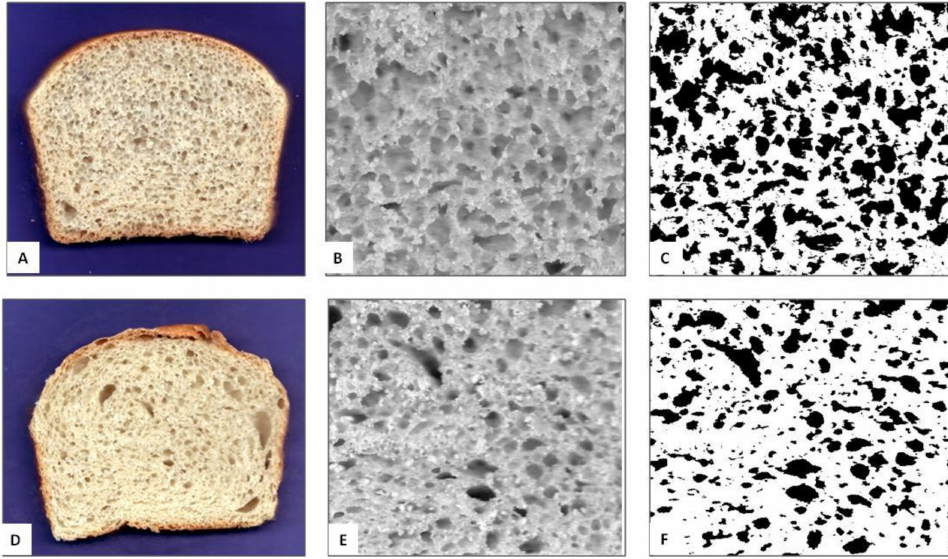
Figure 1. Representative images of the bread samples, regions of interests and the binarized images employed for morphological characterization of crumb structure. ( A , D ) represent CB and GFB, respectively; ( B – E ) and ( C – F ) represent the regions of interest (ROIs) and binarized images for CB and GFB,